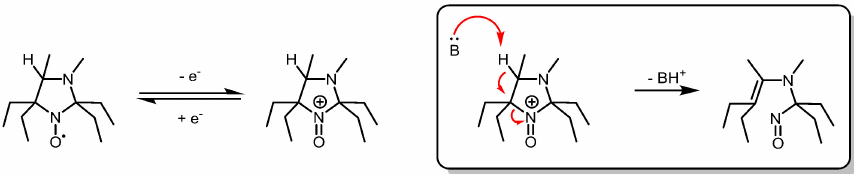
Figure 12. Imidazolidine nitroxides bearing a hydrogen atom at position four of the heterocycle are oxidized to unstable oxoammonium cations by monoelectronic oxidants (superoxide, peroxyl, or lipid-derived radicals). Proton abstraction by a weak base (B) induces irreversible ring